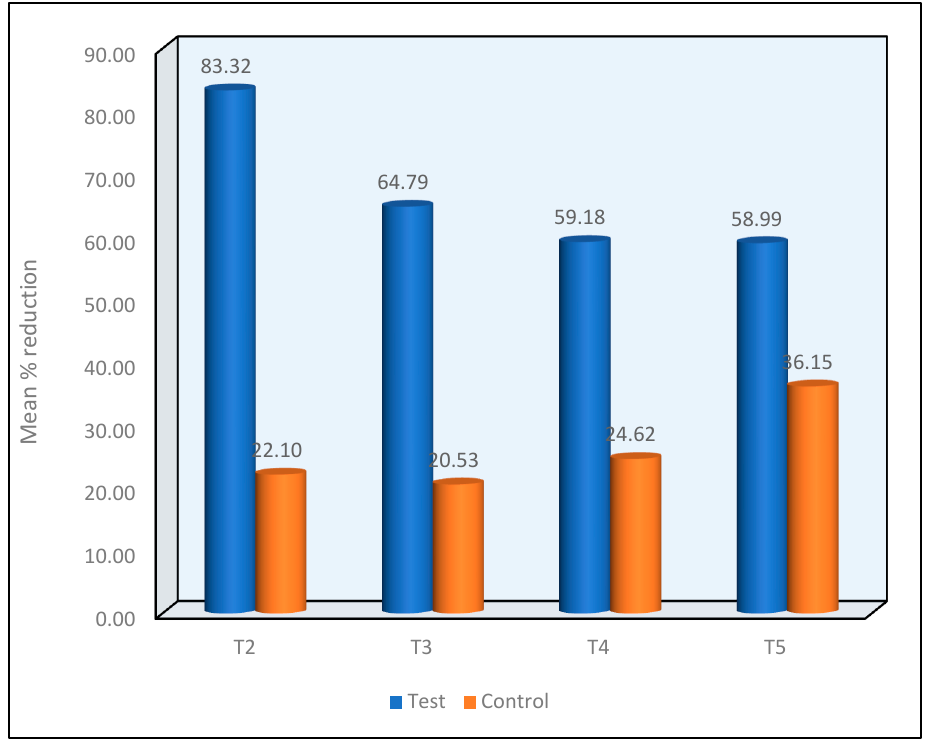
Figure 7. Mean percentage reduction in VAS between the two groups at the T2 to T5 Time Inter- vals.